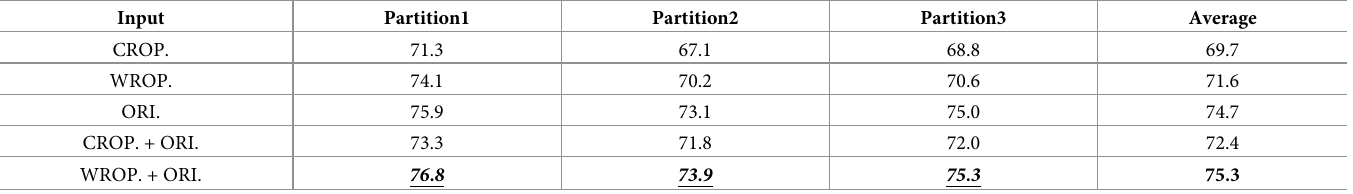
Table 5. The effect of different combinations of input on hmdb-51 about accuracy. Input Partition1 Partition2 Partition3 Average CROP. WROP. ORI. CROP. + ORI. WROP. + ORI.